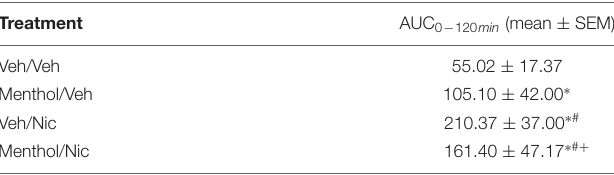
TABLE 1 | Effects of menthol pretreatment on nicotine-induced antinociception in the hot plate test.